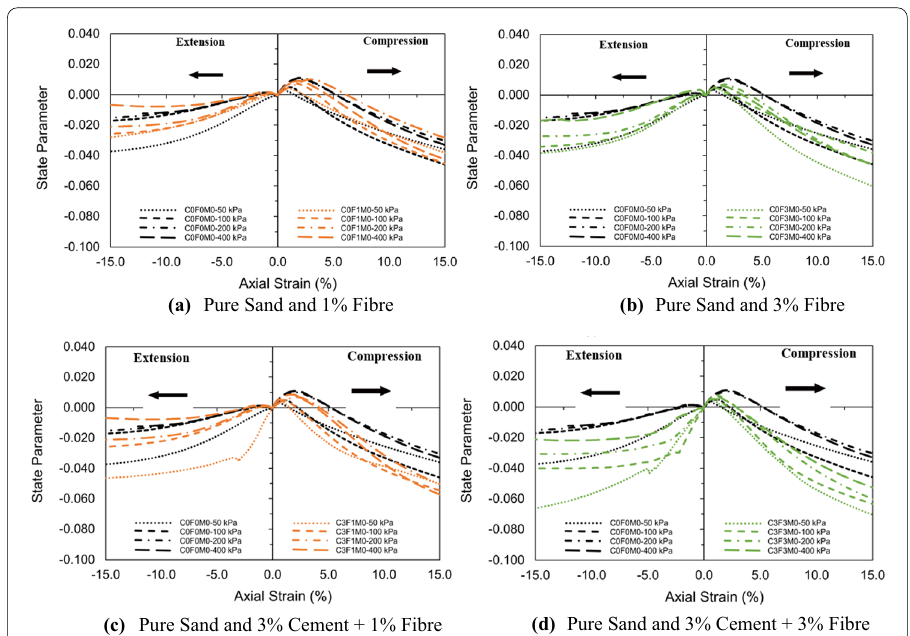
Fig. 7 State parameter ( ψ pm ) vs axial strain ( ǫ a ) curves from CIDcompression and extension tests for unreinforced, fibre, and fibre reinforced cemented Toyoura sand specimens consolidated to varying mean effective stresses ( p’ ) a Pure sand and 1% fibre b Pure sand and 3% fibre c Pure sand and 3% cement fibre d Pure sand and 3% cement 3% +